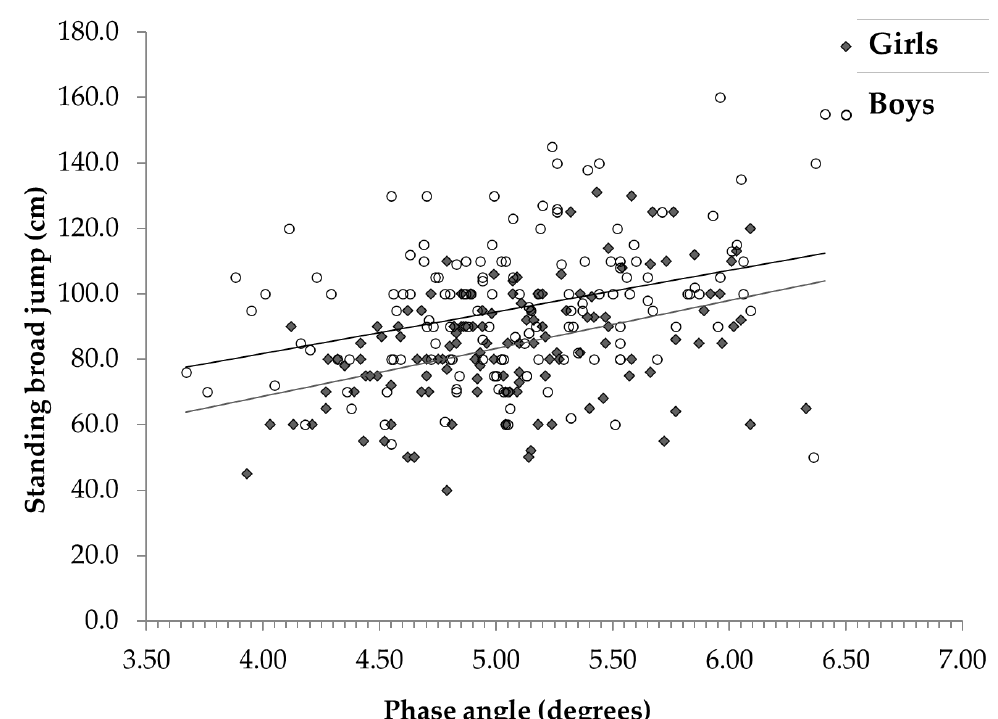
Figure 2. Relationship between standing broad jump and phase angle at 50 kHz in boys and girls. Table 3. Health-related fitness tests expressed for tertiles of phase angle in boys and